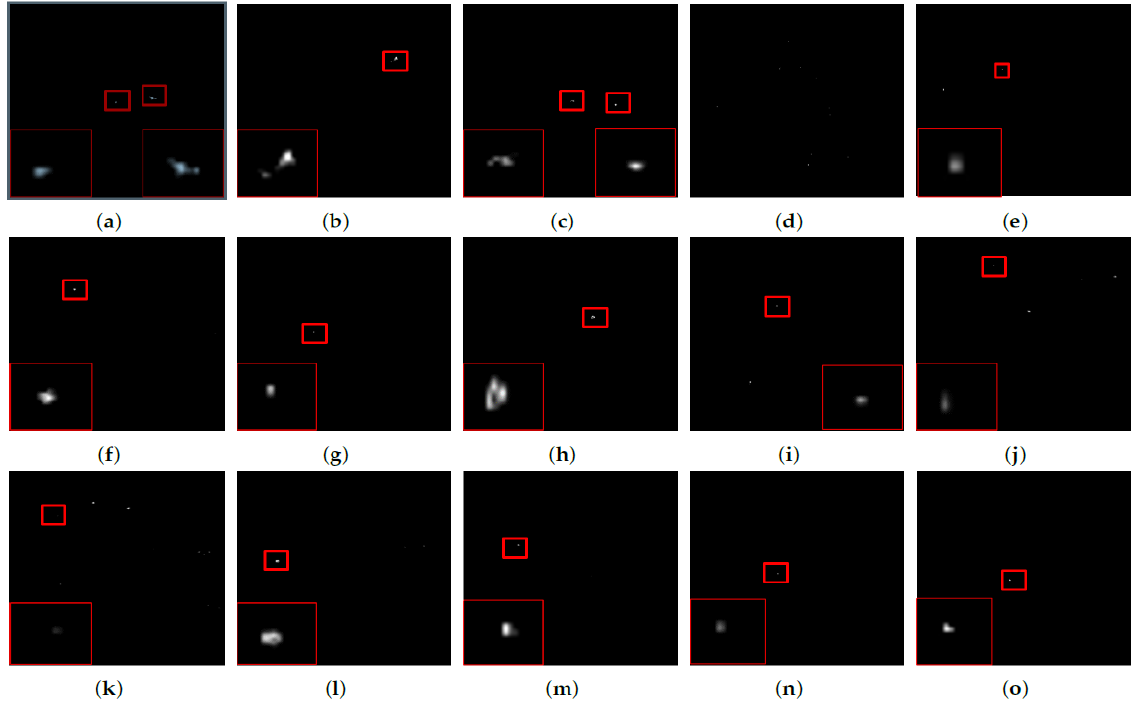
Figure 19. The detection results of the original images’ added noise with mean 0 and variance 0.005. ( a – o ) represent the corresponding scenes in Figure